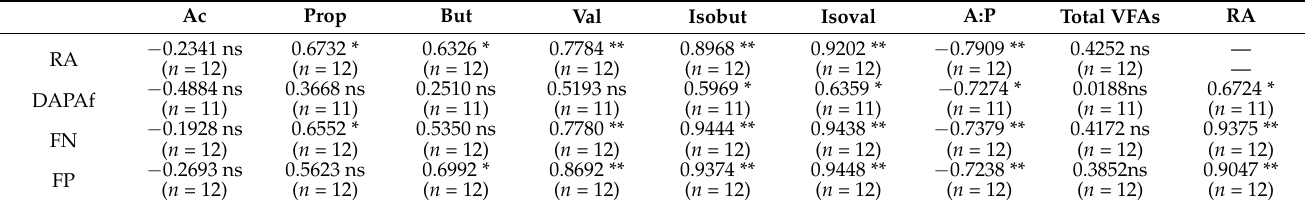
Table 2. Pearson’s correlation coefficients among the fecal contents of 2,6 diaminopimelic acid (DAPAf, mg/g MO), nitrogen (FN, %) and phosphorus (FP, %), and acetic (Ac), propionic (Prop), butyric (But), valeric (Val), isobutyric (Isobut), and isovaleric acids (Isoval), acetic:propionic